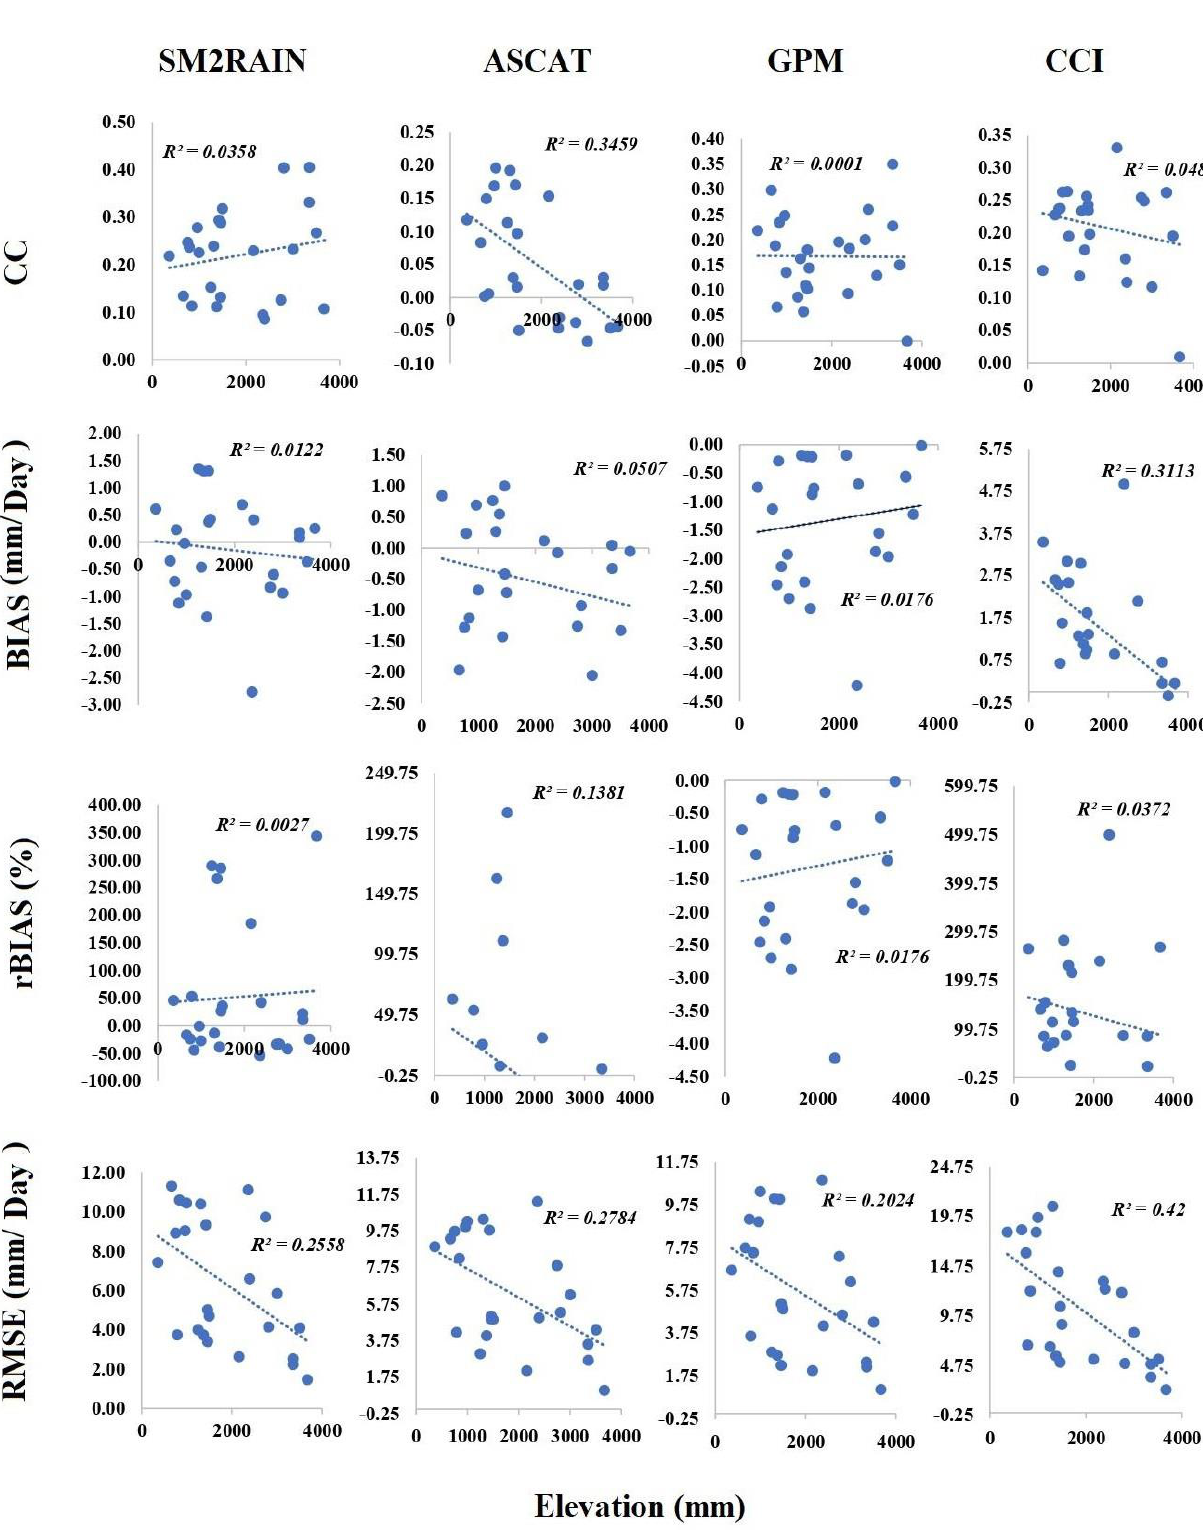
Figure 6. Impact of elevation on all evaluation indices on daily scale.